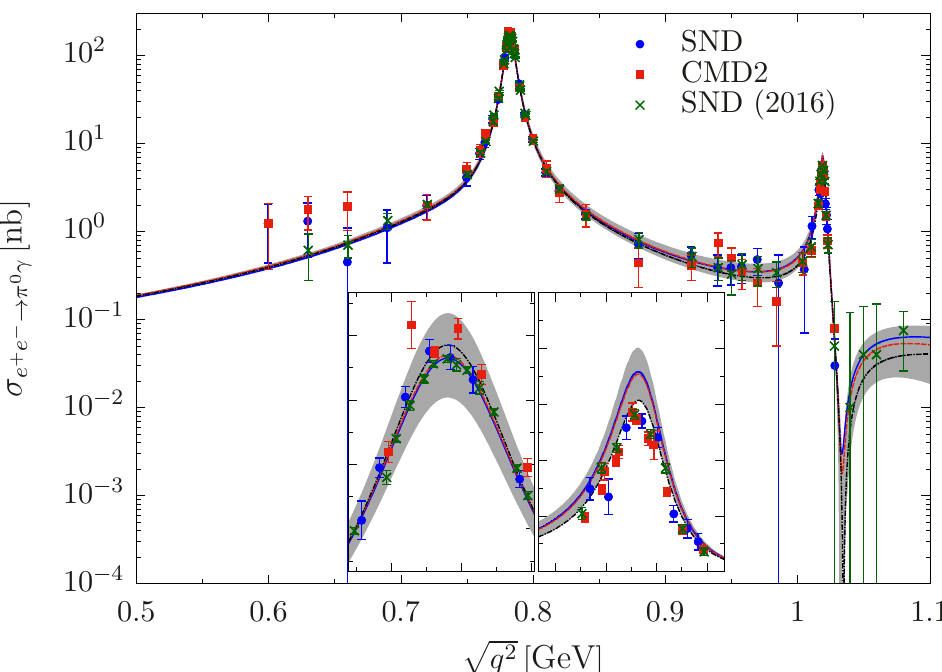
Figure 7. The e + e (cid:0) (cid:25) 0 (cid:13) cross section calculated from the once-subtracted TFF (blue solid ! line), the unsubtracted TFF (red dashed line), and [62] (black dot-dashed line), compared to the data of SND [167, 168], CMD2 [169], and SND (2016) [170]. The inserts show the same plot around the ! and (cid:30) peaks, respectively. The gray band indicates our uncertainty estimate for the unsubtracted